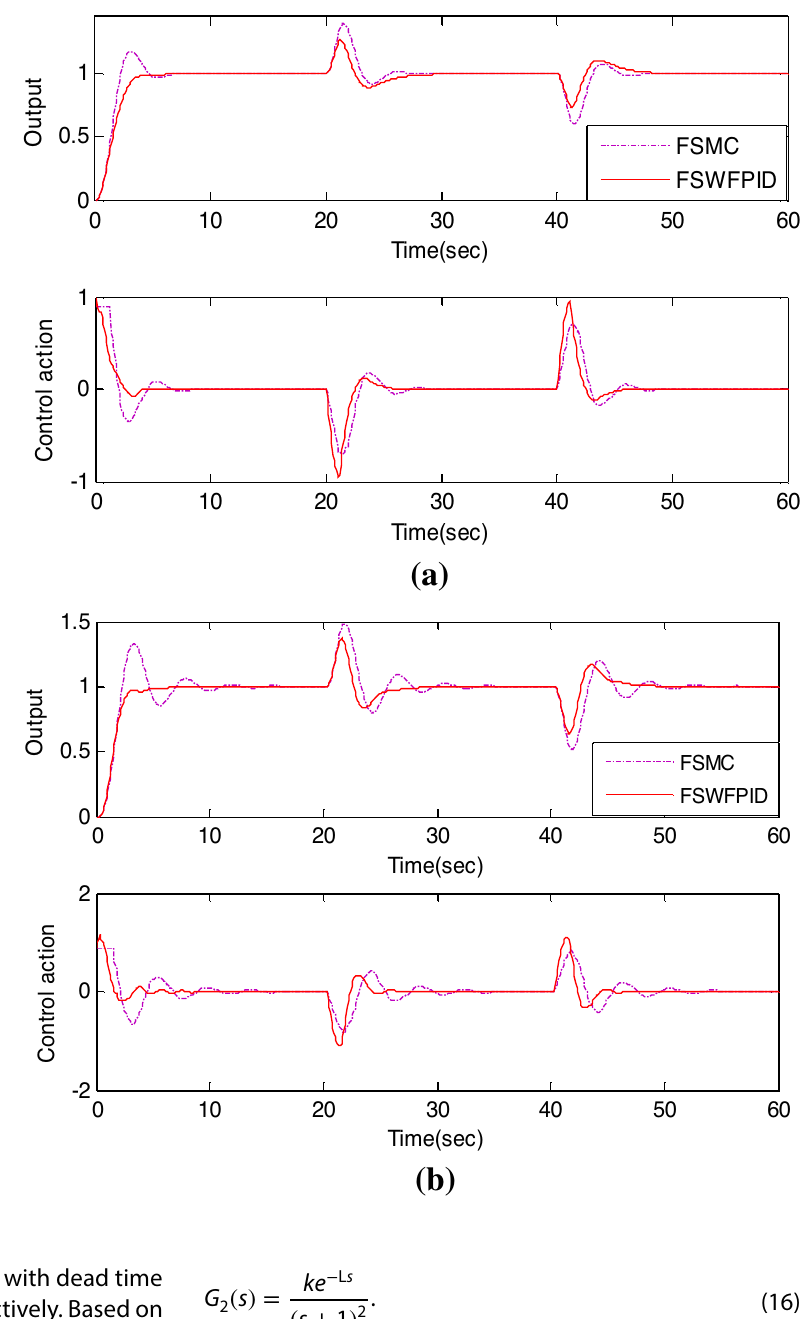
Fig. 7 Comparison among responses and control actions with FSMC for Model I using 49 rules during set point response and with load variation for a L = 0.05 s, b L = 0.3